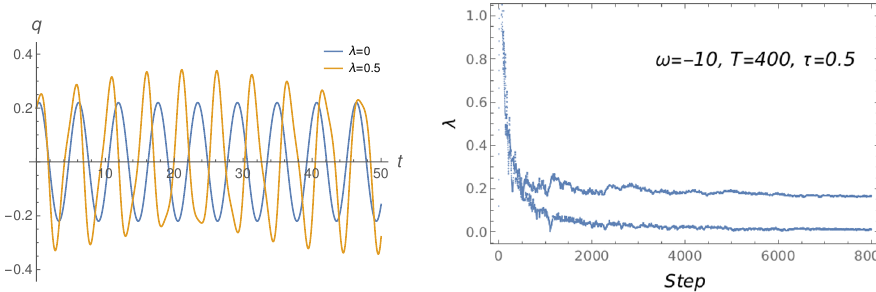
Figure 9 . Left: spinning string ansatz for undeformed, λ = 0 , and deformed, λ = 1 / 2 , LL model. We plot the solution with ω = − 0 . 15 , initial conditions q (0) = 0 . 2 , q (1) (0) = 0 . 1 (and q (2) (0) = 0 , q (3) (0) = 0 in the deformed case). Right: plot of the two largest LCEs for LL model with parameters (4.23) and ω = − 10 . The initial conditions are q (0) = 0 = p 0 (0) = p 1 (0) , q (1) (0) = 1 The total evolution time is T = 400 which is broken into 8000 iterative